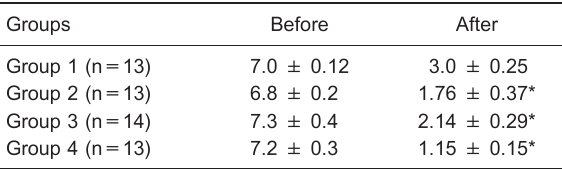
7.2 ± 0.3 1.15 ± 0.15* Data are reported as means ± SE. Group 1: normal 25(OH)D levels and amitriptyline therapy alone; group 2: normal 25(OH)D levels and vitamin D supplementation plus amitriptyline; group 3: mildly deficient 25(OH)D levels and vitamin D supplementation plus amitriptyline; group 4: severely deficient 25(OH)D levels and vitamin D supplementation plus amitriptyline. *P , 0.05 compared to group 1 (one-way ANOVA).